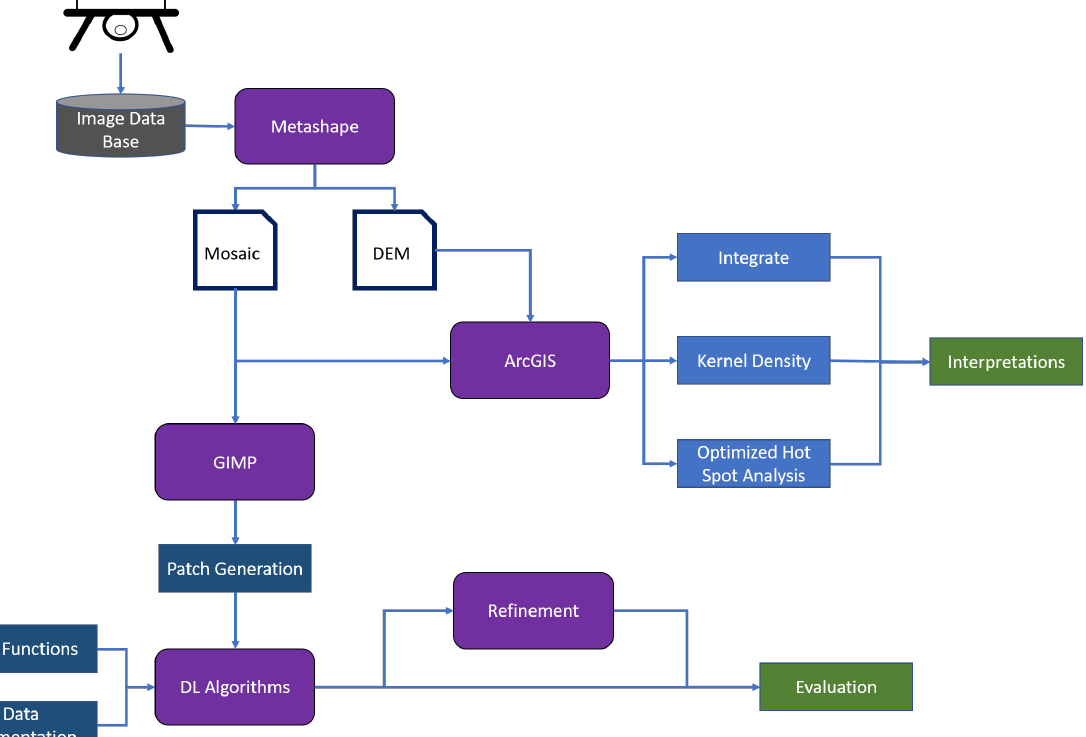
Figure 2. Workflow of the paper. Gray is our data base; purple boxes show softwares/programs used in this study; white boxes with a blue outline are generated files; dark blue are processes used for the deep learning (DL) classification and detection; light blue are tools in